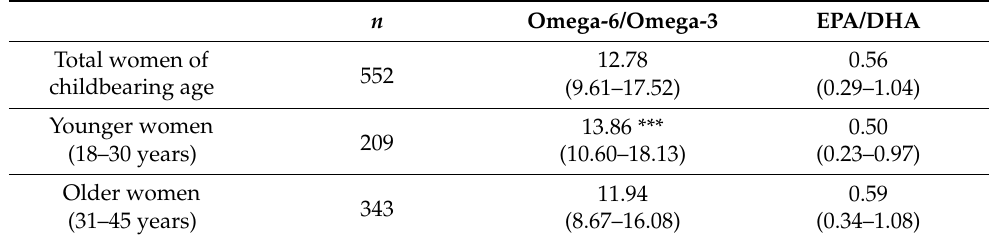
Table 6. Omega-6/Omega-3 and EPA/DHA dietary intake ratios among women of two childbearing age groups from the ANIBES